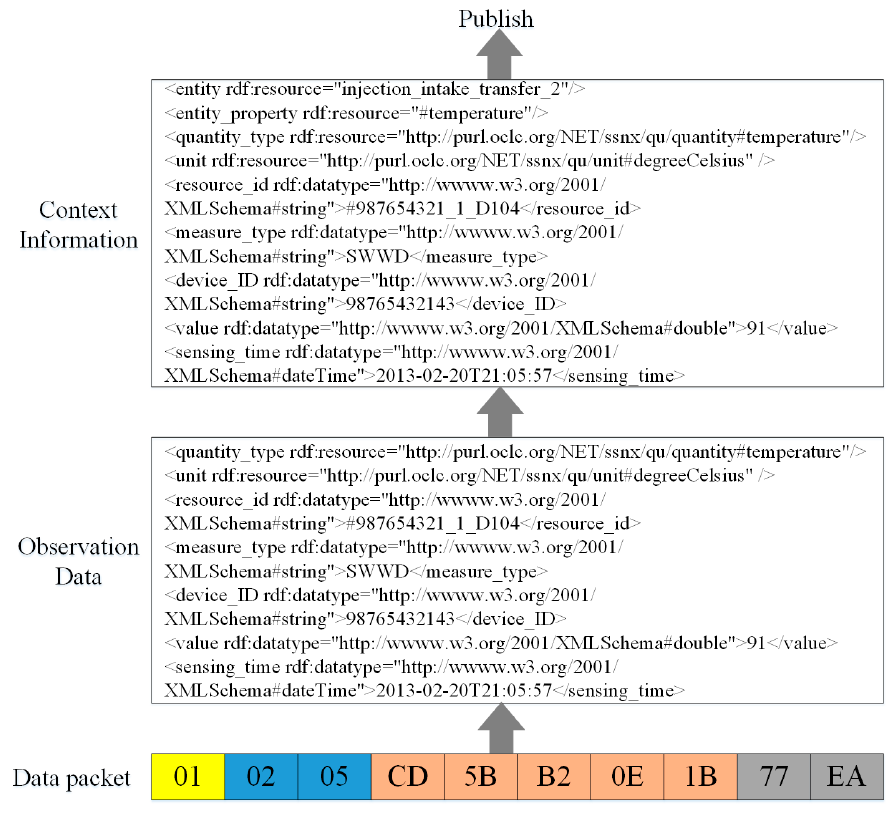
Figure 12. Information publishing process.